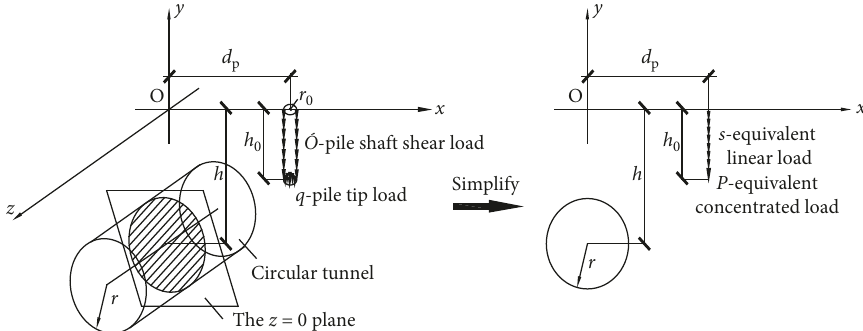
Figure 2: Conceptual model of the theoretical procedure, reproduced from [15].